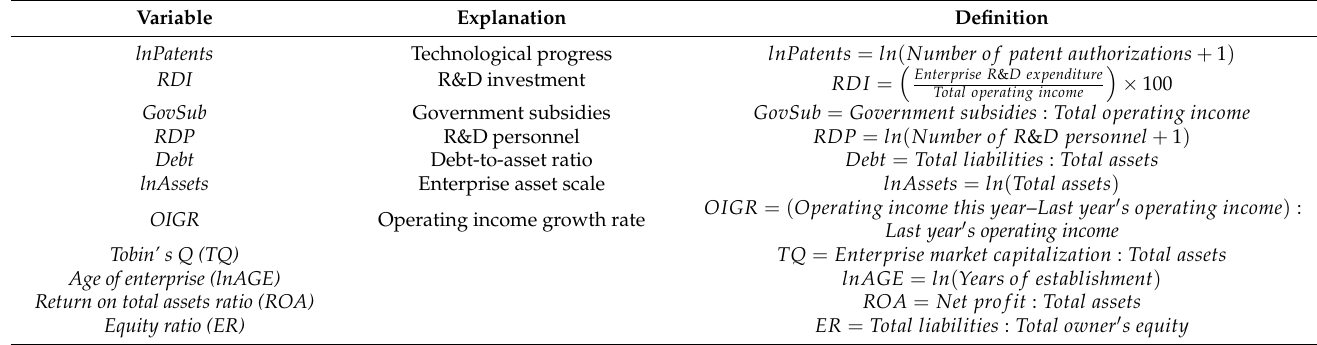
Table 1. Variable description